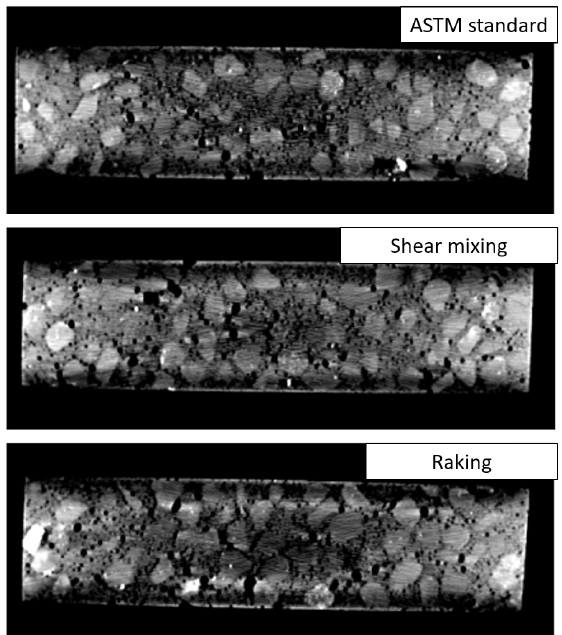
Figure 7. Characteristic image slices from XCT scans of the samples taken from each type of casting method. Aggregate centroid positions were extracted by assuming approximately circular and/or oval cross ‐ sections of aggregates, they were marked in each imaged slice, and confirmed by replication of the selection process. The aggregates were identified as circular or oval based on limits set for the relative sizes the axes of an ellipse matching the region of similar gray ‐ scale intensity. Images were spaced closely such that each aggregate appears in multiple scans. This allowed regions that were identified as an aggregate in any image to be confirmed with similar regions in adjacent scans. On average 6,300 aggregate centroid positions were identified for each casting method. Each set of scans captured a total imaged volume, 𝑉 . The set of 𝑁 aggregate positions in this volume were analyzed using a radial distribution function normalized by the number density of the system multiplied by the volume of the spherical shell. The relative radial distances from each aggregate centroid to all other aggregate centroids, were binned by radial distances, 𝑑𝑟 , and normalized by 𝜌 4 𝜋𝑟 (cid:2870) 𝑑𝑟 . The results are plotted in Figure